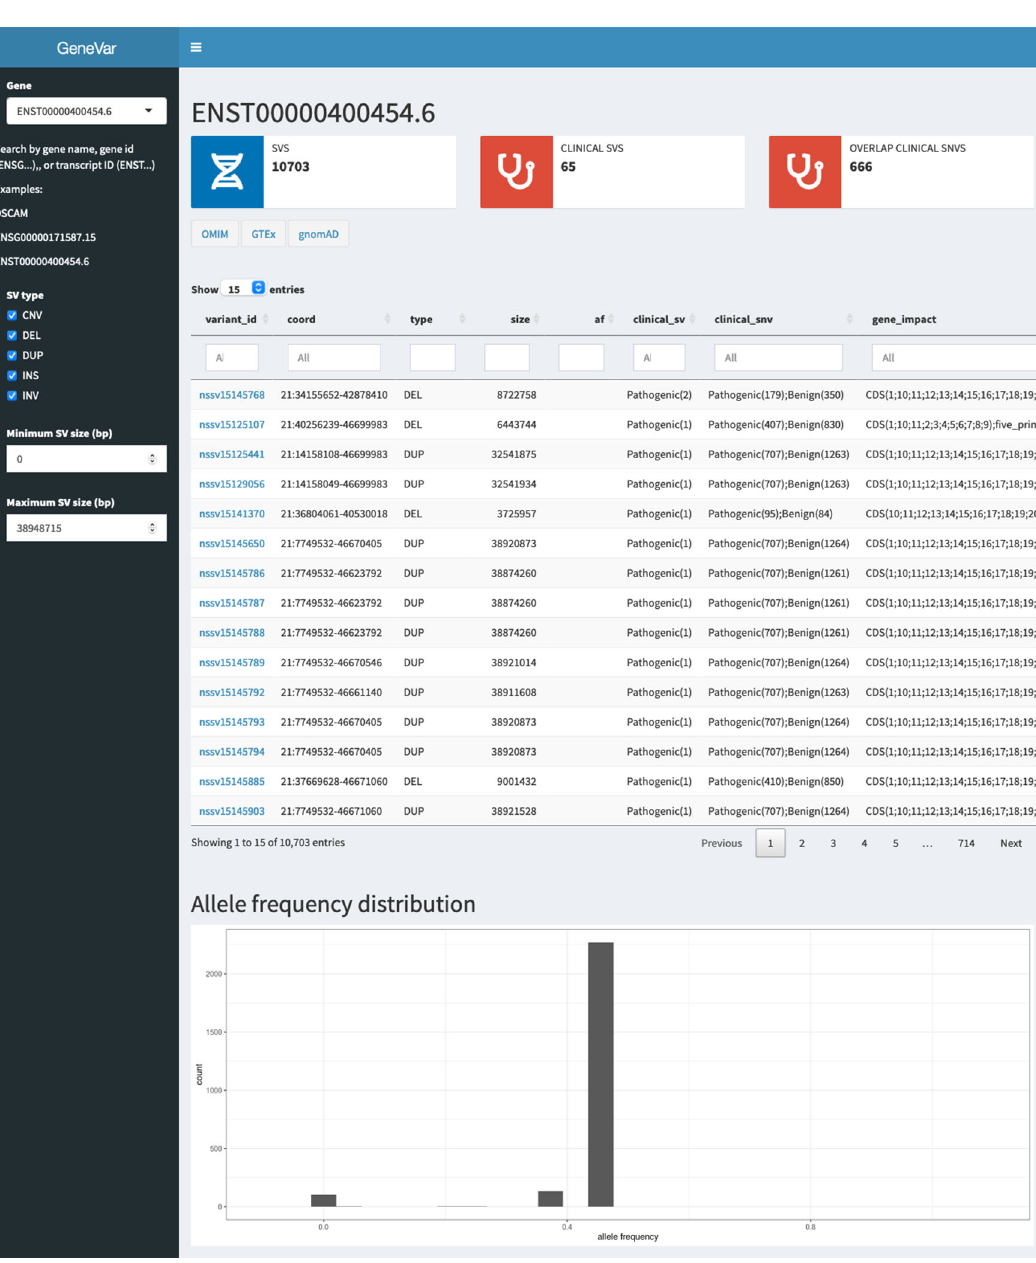
Figure 16. User interface of GeneVar data browser. A description of the elementary transcript details for the gene of interest. This includes the Ensembl transcript ID, Ensembl Gene ID, number of exons and genomic coordinates as described in the GRCh38